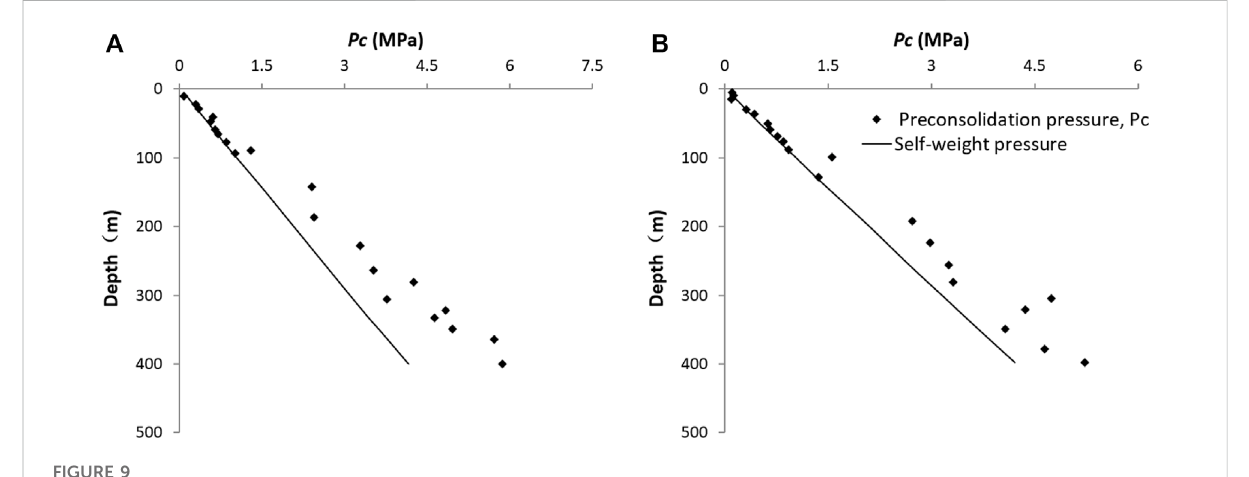
FIGURE 9 Change of Pc with depth in the borehole CZ-1 (A) and CZ-2 (B)